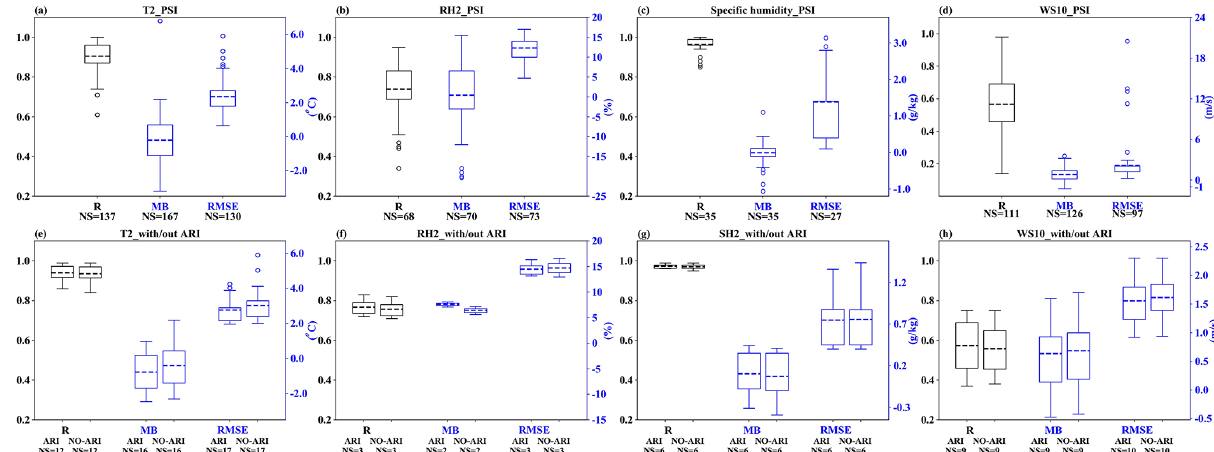
Figure 3. Quantile distributions of R , MB, and RMSE for simulated surface meteorological variables by the five coupled models (WRF- Chem, WRF-CMAQ, GRAPES-CUACE, WRF-NAQPMS, and GATOR-GCMOM) (a–d) and comparisons of statistical indices with and without ARI (e–h) in Asia.